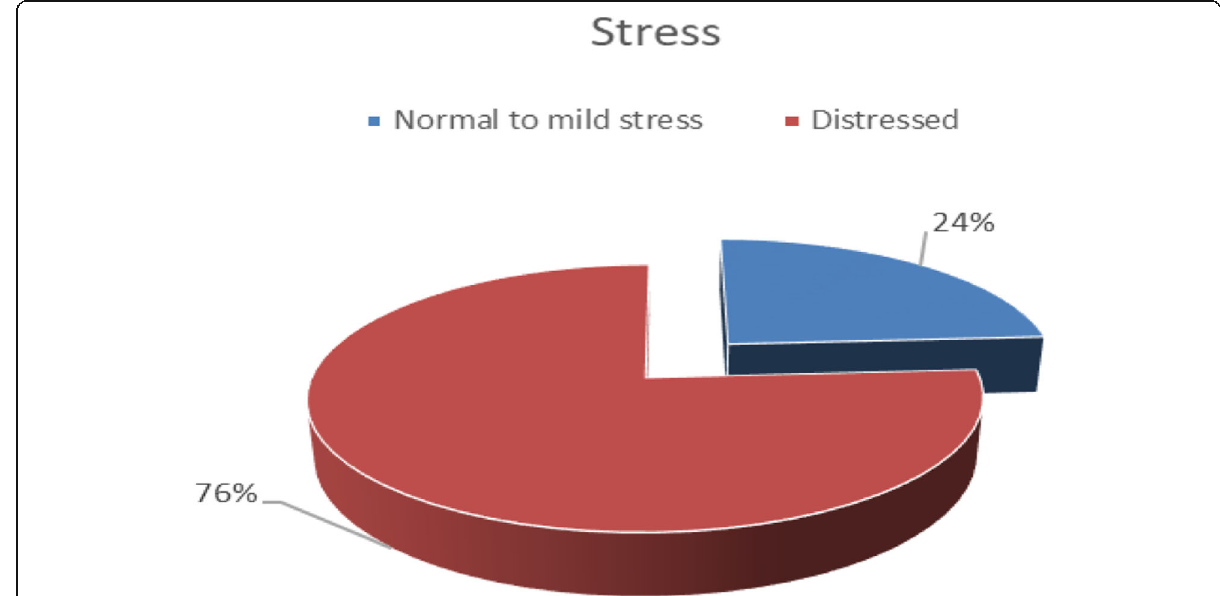
Fig. 1 Percentage of